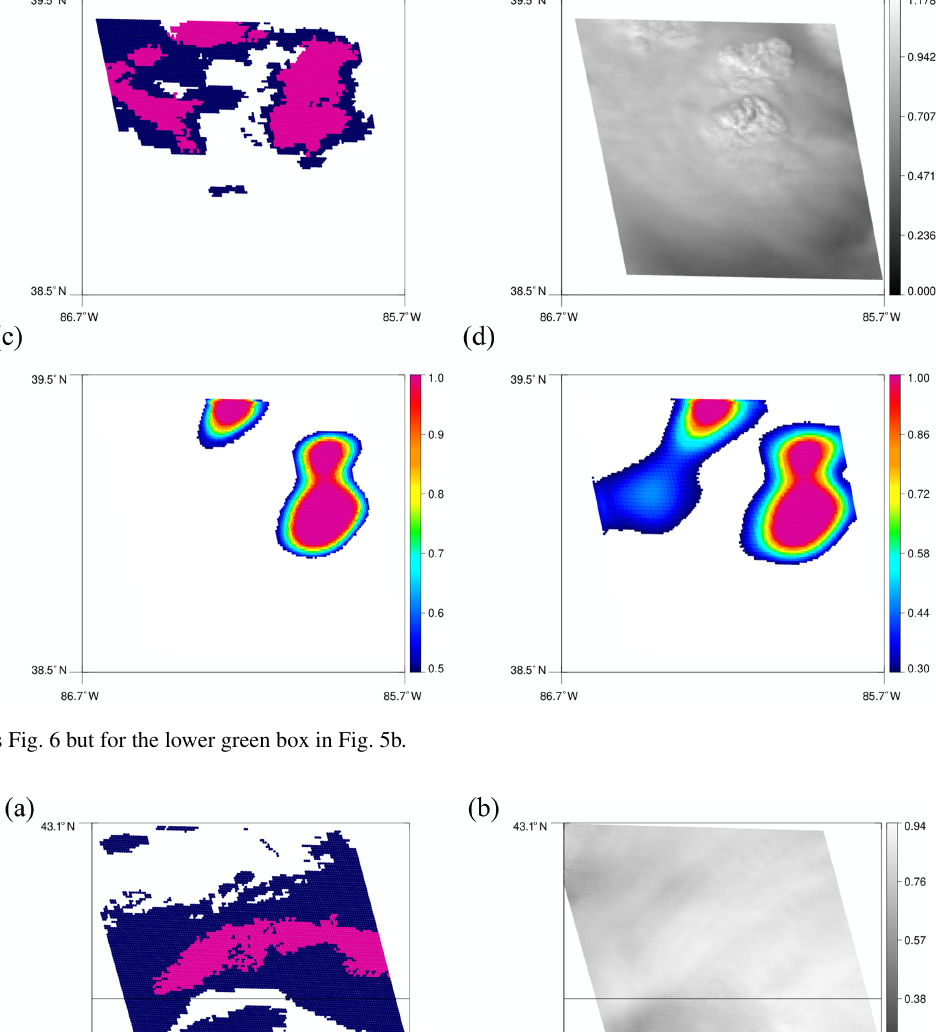
Figure 9. Same as Fig. 6 but for the lower green box in Fig. 5b.